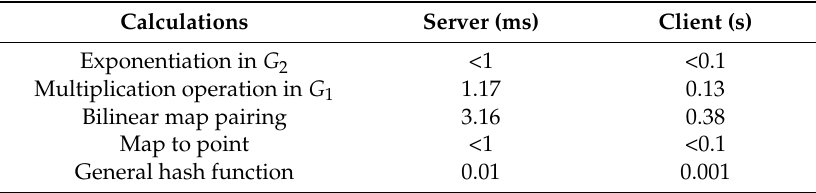
Table 14. Time comparison of various cryptographic